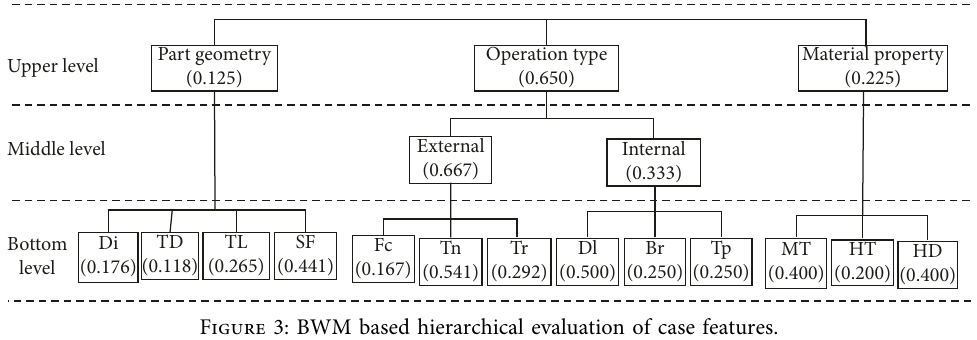
Figure 3: BWM based hierarchical evaluation of case